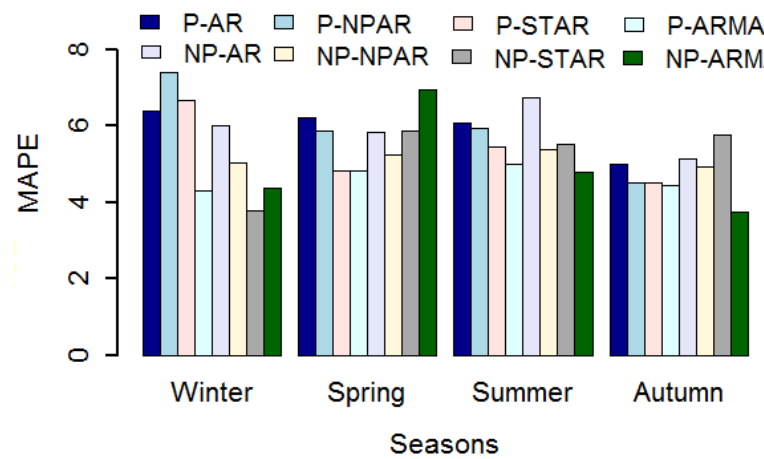
Figure 5. One month ahead post-sample forecasts MAPEs with respect to seasons of the year.